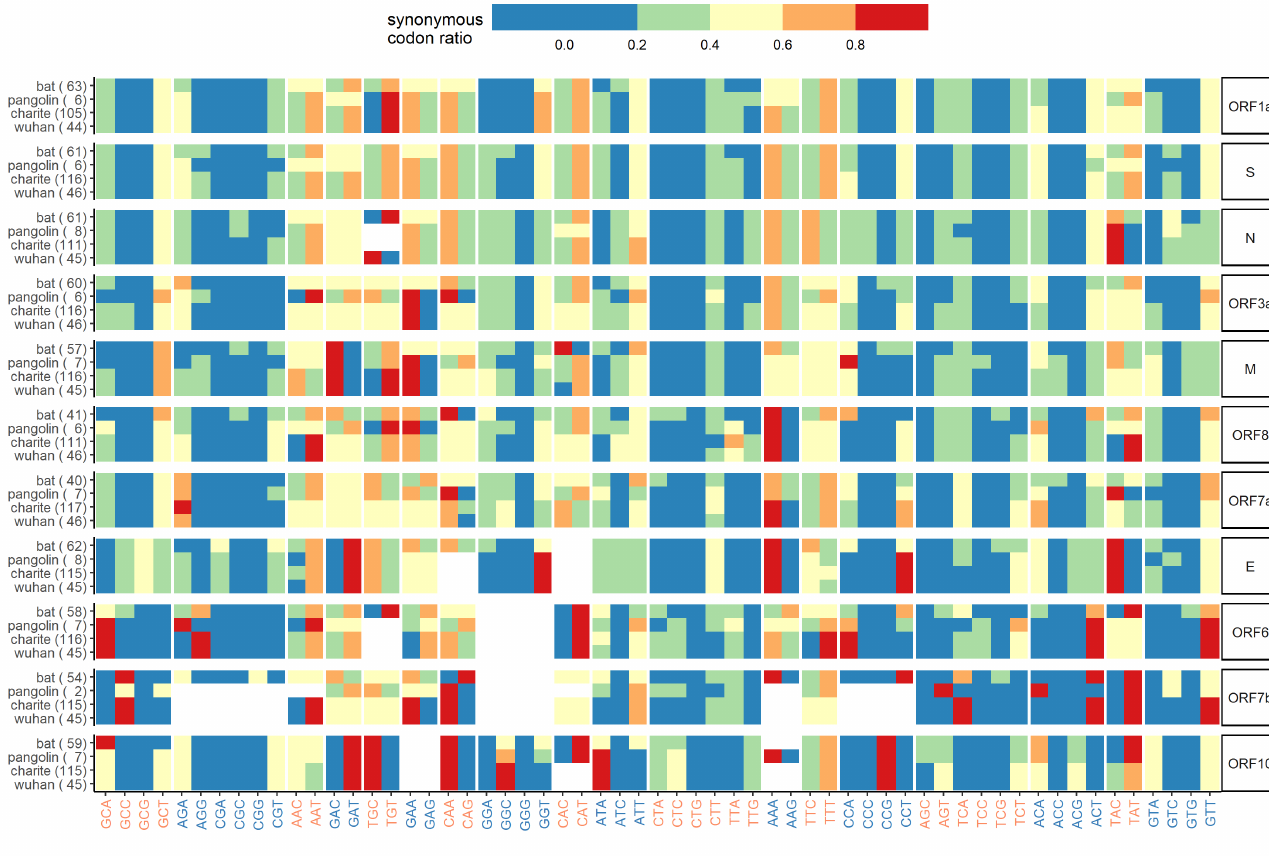
Figure A8. Synonymous codon ratios are the ratio between the number of a given codon divided by the total number of codon coding for the same amino acid. By sorting this ratio in blocks of synonymous codons, this heatmap illustrates the preferential codons for each amino acid for each dataset across all genes. A number of codon usage bias are consistent across most genes and datasets. For instance, GCT is preferentially used for Ala (Alanine) and GTT for Val (Valine). On the whole, there seem to be less of a preferential codon use for bat, especially in longer genes or when multiple genes are accounted for, as per indicated by the higher frequency of more evenly distributed codon within each amino acid (i.e., for the bat dataset, the heatmap colours are of a similar level within each amino